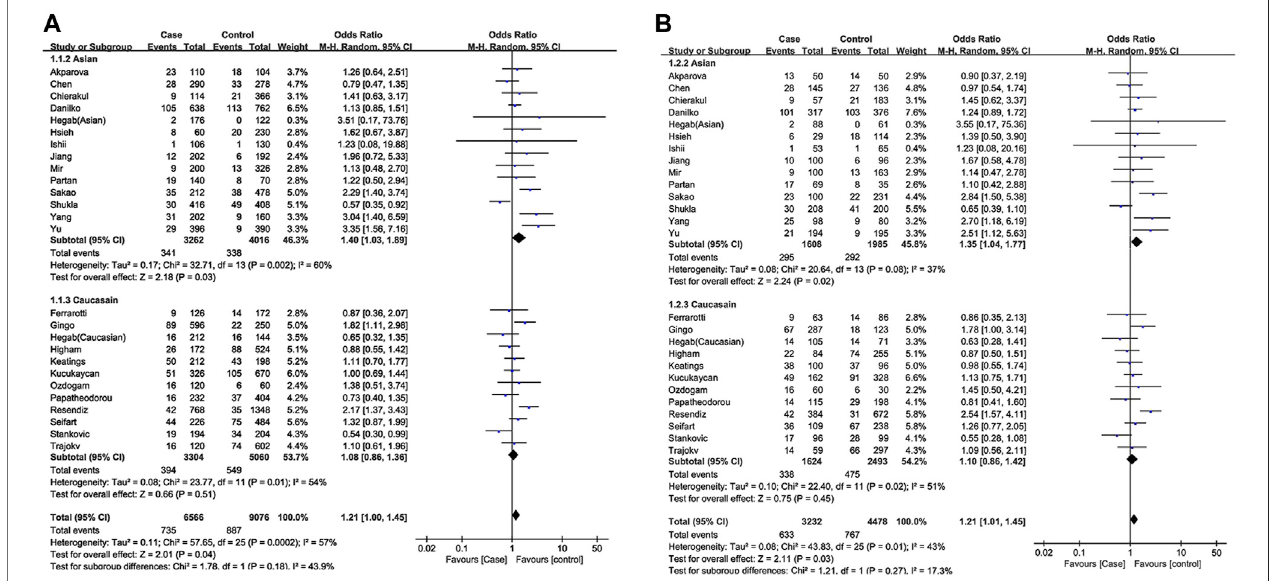
FIGURE 2 | Forest plot of TNF- α -308 polymorphism and COPD risk [ (A) : overall for A vs. G, (B) : overall for GA vs. GG].